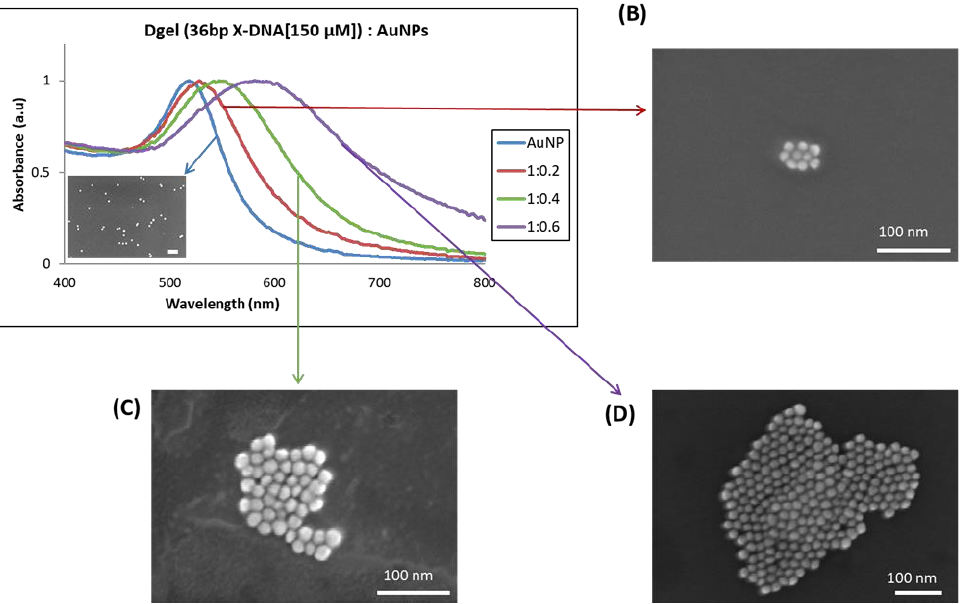
Figure 6. UV visible analysis of plasmonic redshift and SEM image analysis with the correlative change in sizes, ( A ) The gradient redshifts in Dgel: AuNPs peak at constant concentration with change in the ratios of AuNPs. The observed SEM images of respective samples (Dgel: AuNPs) with a change in molar ratios as ( B ) (Dgel: AuNPs) 1:0.2, ( C ) (Dgel: AuNPs) 1:0.4, ( D ) (Dgel: AuNPs) 1:0.6.